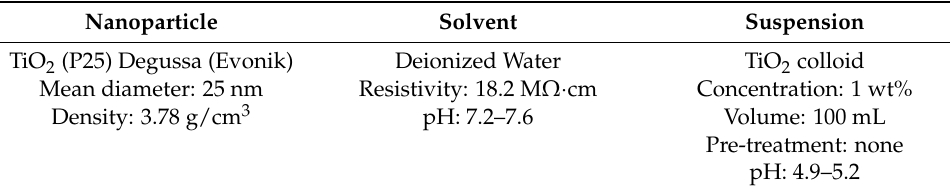
Table 1. Physical properties of the nanoparticles, solvent, and suspension used in the experiment.